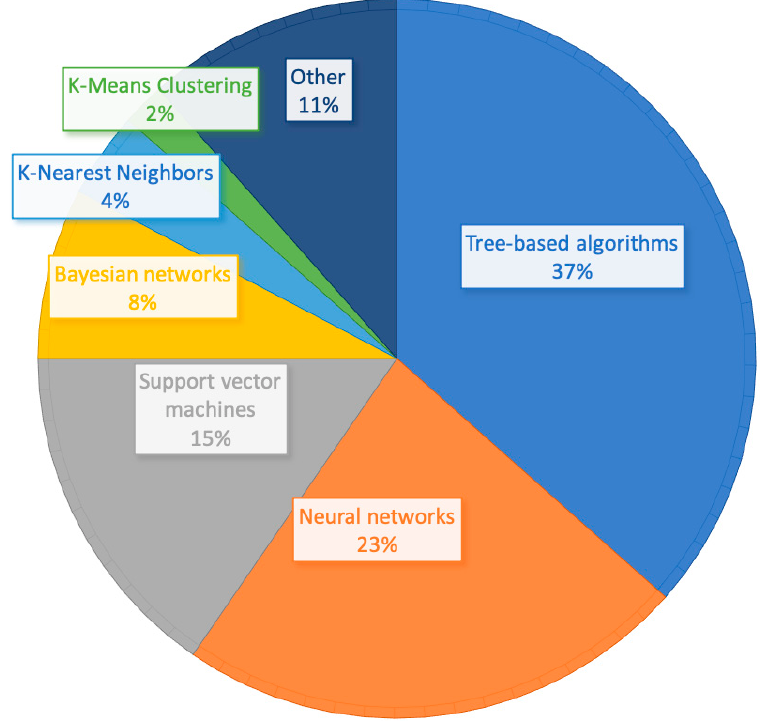
Figure 3. Frequency of ML techniques employed among the articles included in the review.